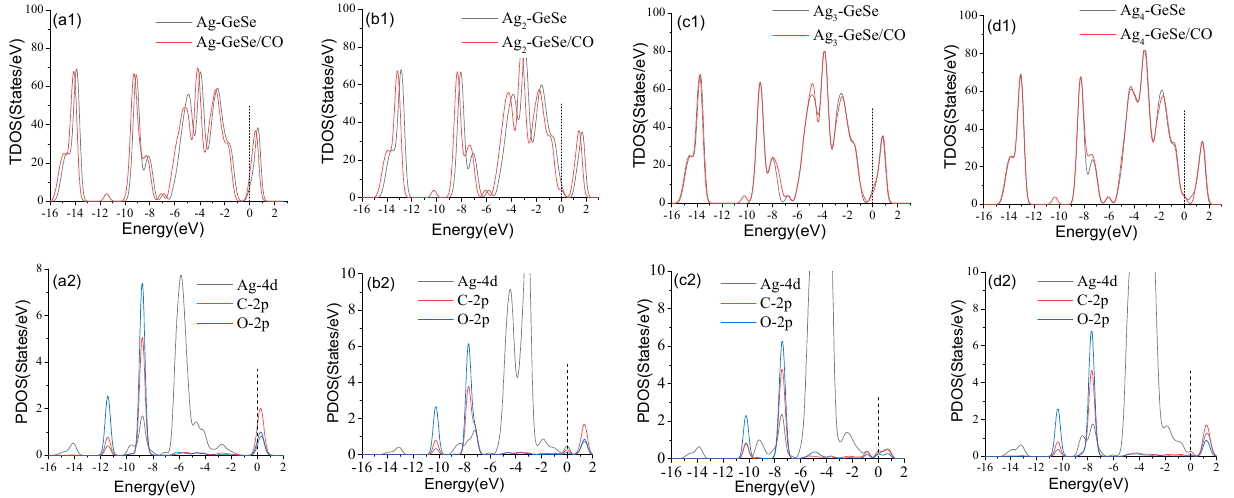
Figure 5. TDOS and PDOS of gas molecules adsorption on Ag n -GeSe. ( a1 ) TDOS of CO on Ag modified GeSe ( b1 ) TDOS of CO on Ag 2 modified GeSe ( c1 ) TDOS of CO on Ag 3 modified GeSe ( d1 ) TDOS of CO on Ag 4 modified GeSe; ( a2 – d2 ) are PDOS of the corresponding subgraph.